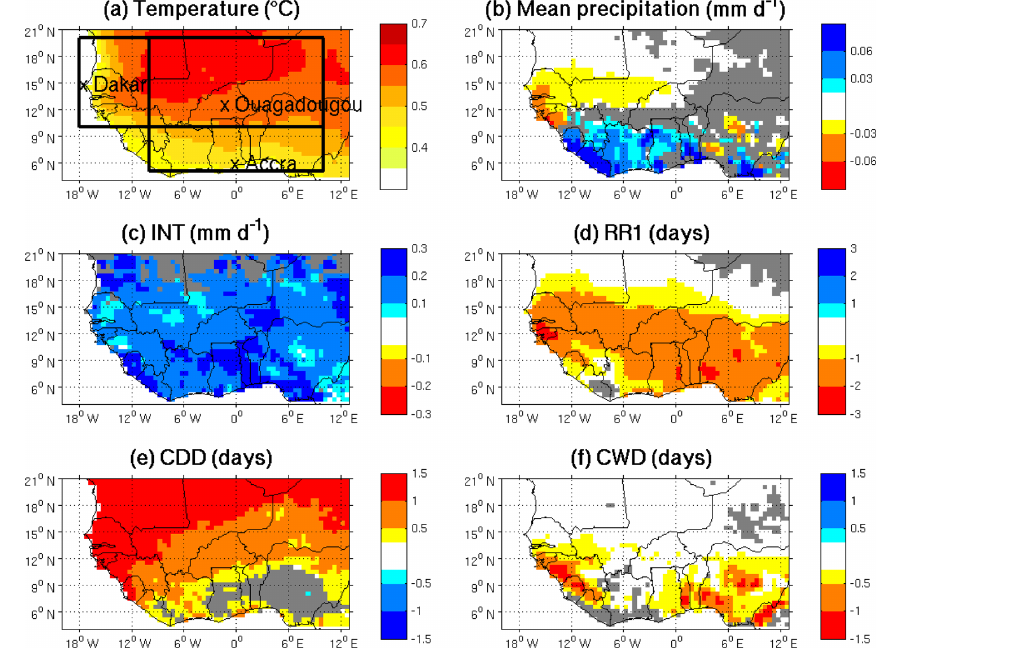
Figure 1. Multimodel mean trend maps (2006–2100) for annual (a) mean temperature ( ◦ C per decade), (b) mean precipitation (mmd − 1 per decade), (c) INT (mmd − 1 per decade), (d) RR1 (days per decade), (e) CDD (days per decade), and (f) CWD (days per decade). Trends that are not significant at 95% according to the Student’s t test are shaded in gray. The black boxes correspond to the three regions of